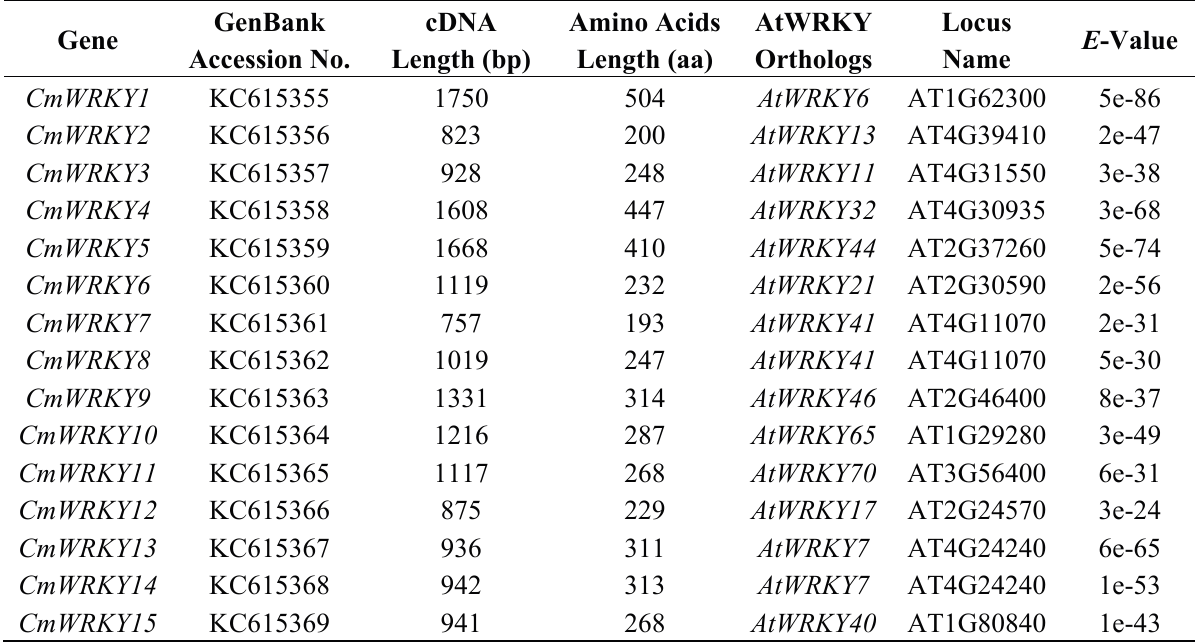
Table 1. CmWRKY gene sequences and the identity of likely A. thaliana homologs . GenBank Gene